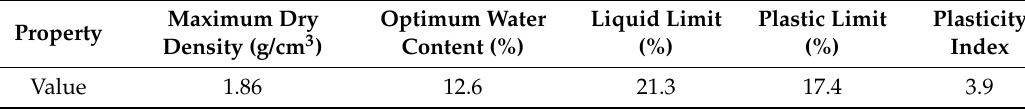
Figure 3. Gradations of the aggregate and soil. Table 4. Physical properties of the